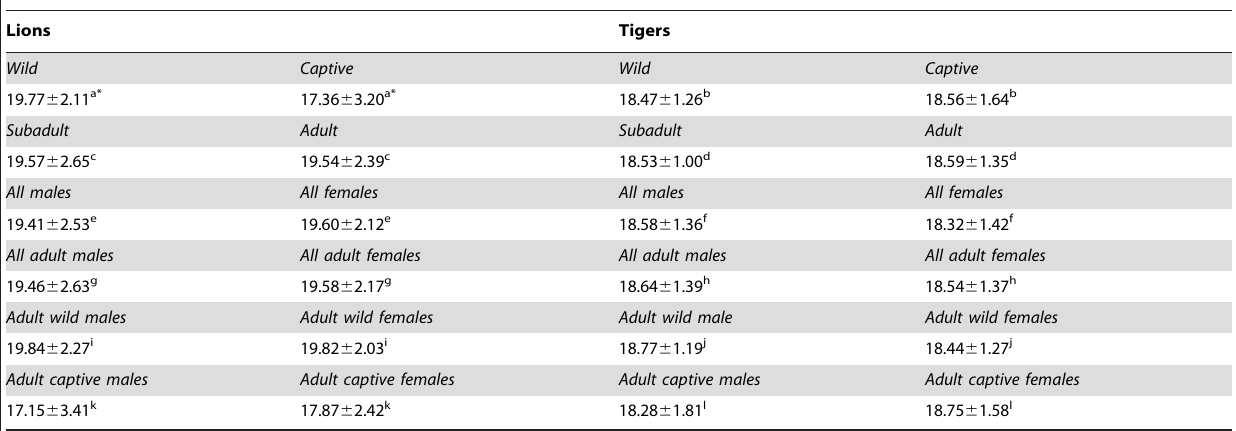
Table 1. Mean FMH (mm) in lions and